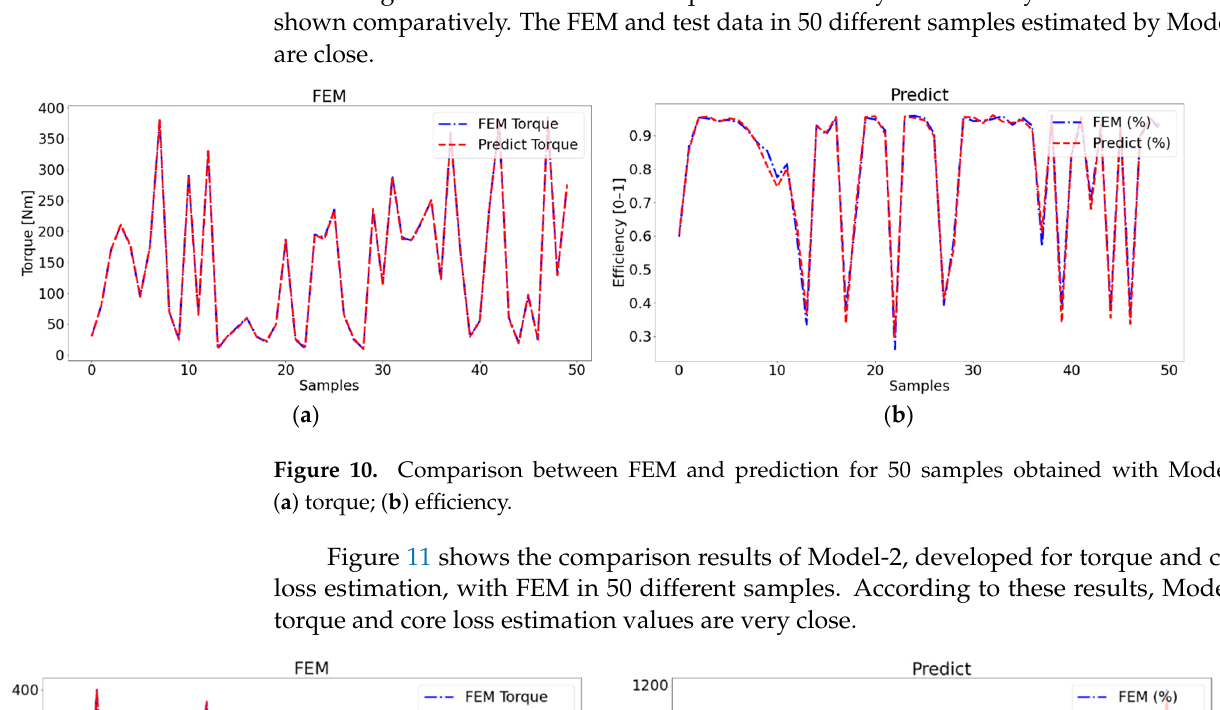
Figure 11. Comparison between FEM and prediction for 50 samples obtained with Model ‐ 2: ( a )